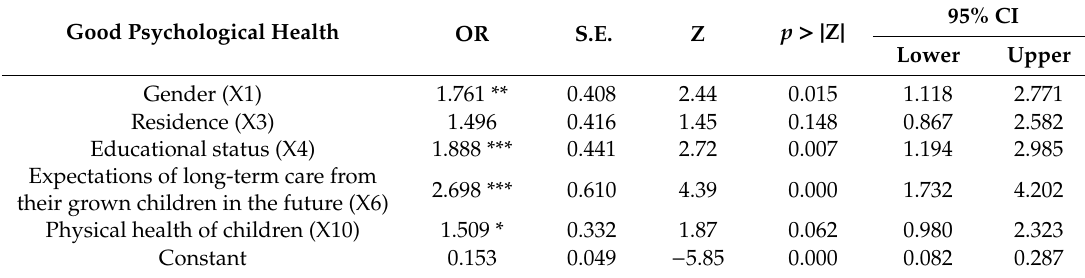
Table A5. Logistic regression results in the seventh step (full